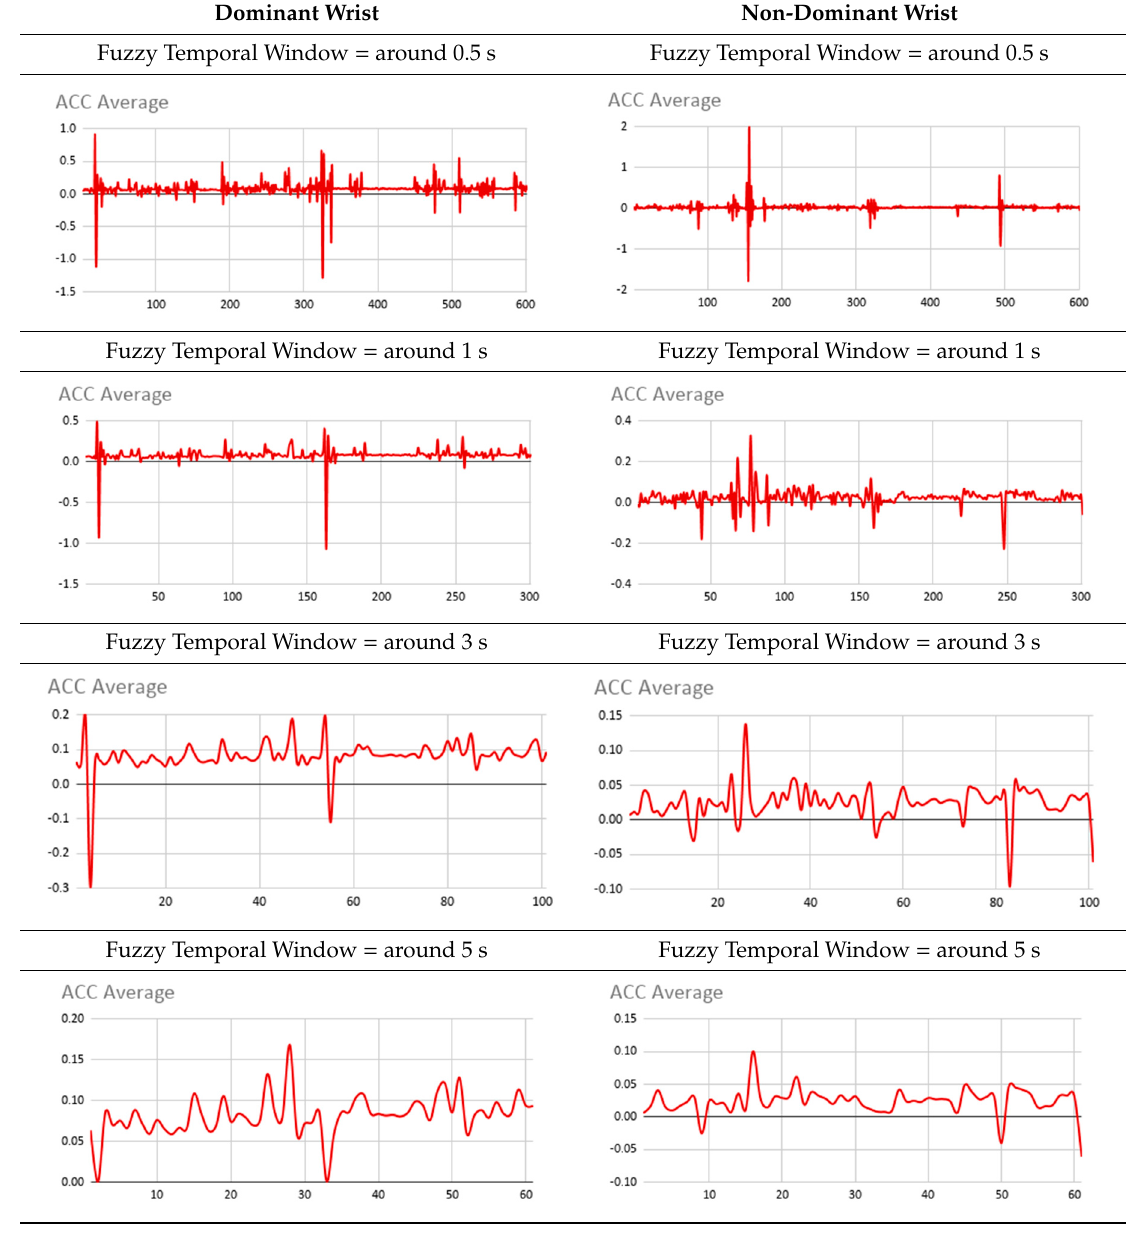
Table 5. Rotation (Gyro) results with different fuzzy temporal windows from both wrists.